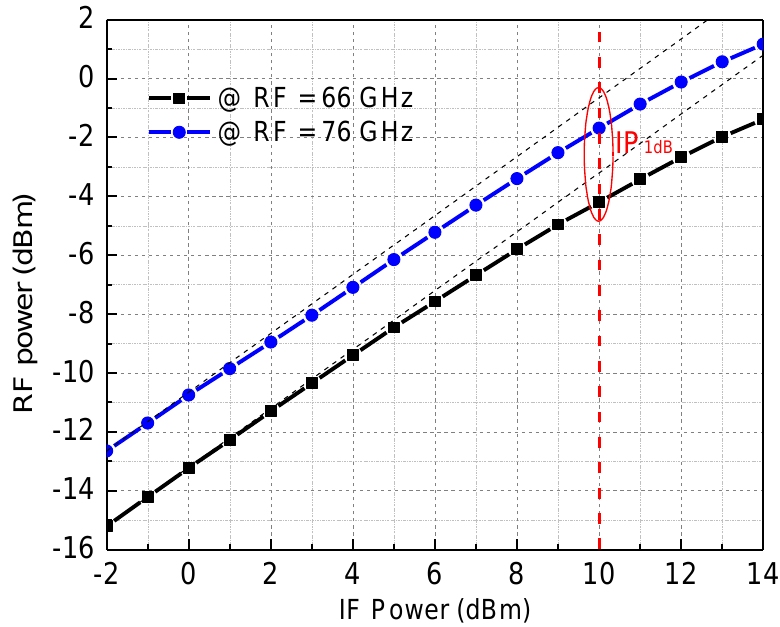
Figure 15. The measured RF output power of the channel emulator varies with the IF input power.